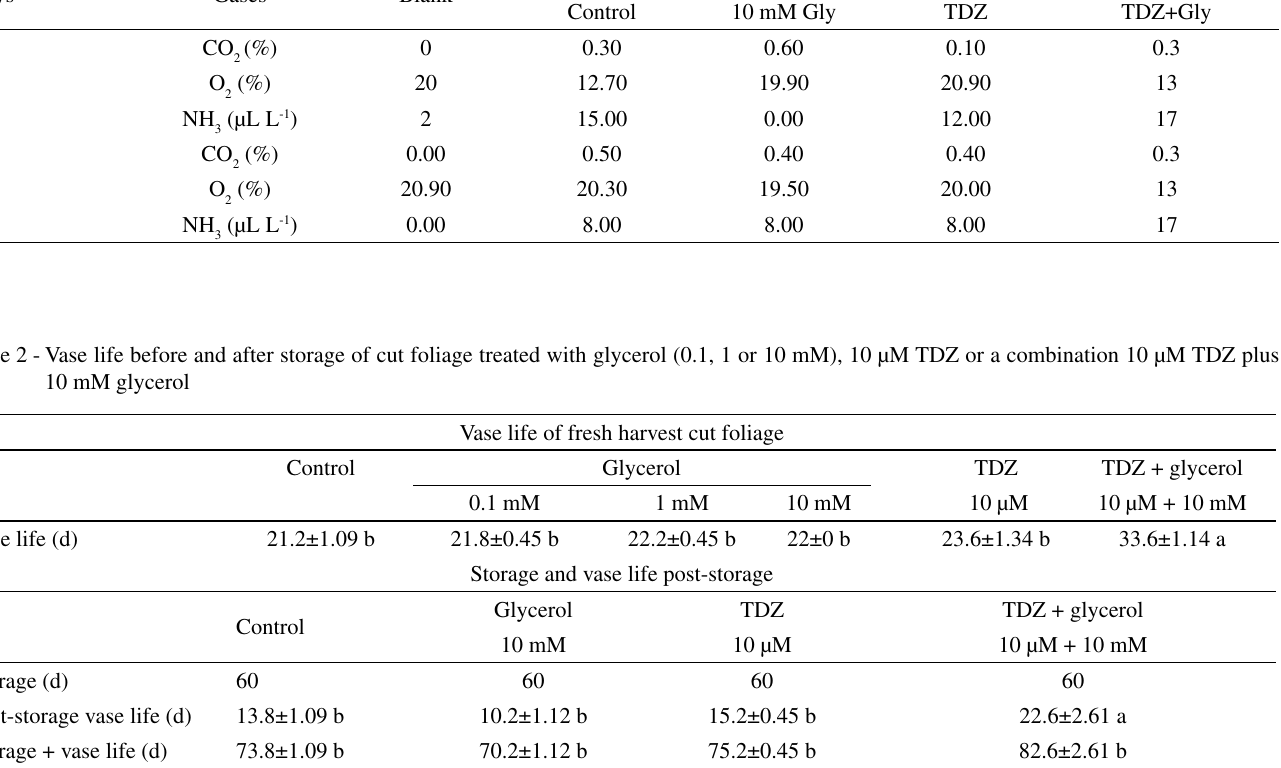
Values are means with standard errors (n=5).